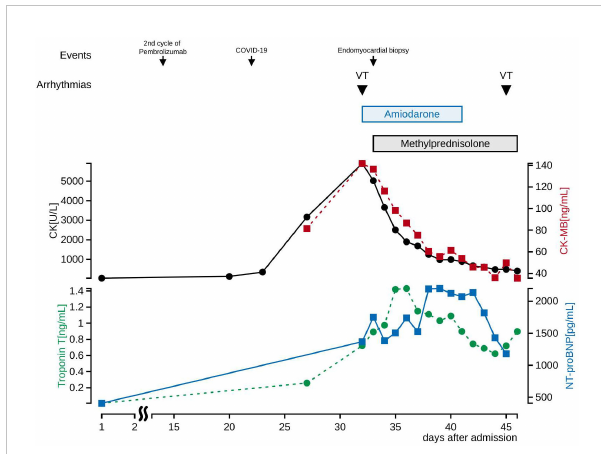
FIGURE 3 Cardiac biomarkers and electrolytes in blood tests after admission. CK and CK-MB decreased initially after methylprednisolone administration, and troponin T and NT-proBNP decreased later. Electrolytes values at the fi rst occurrence of VT were K 4.1 mEq/L, Ca 9.1 mg/dL, Mg 1.8 mg/dL, and at the second occurrence of VT were K 4.7 mEq/L, Ca 8.9 mg/dL, Mg 2.0 mg/dL. Drugs that induce VT are not